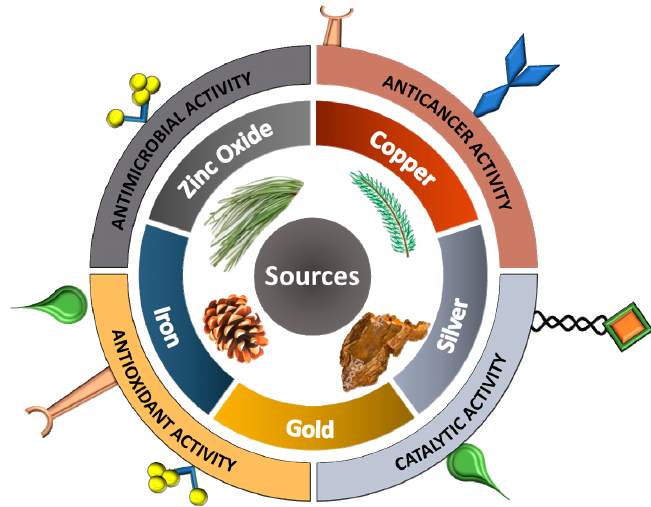
Figure 2. Graphical illustration of conifer sources used for the production of metallic nanoparticles with potential biological activities.